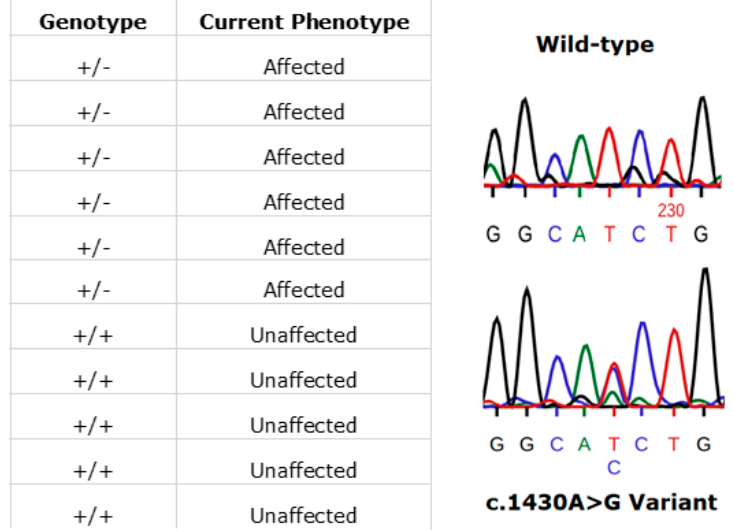
Figure 9. An illustration of patients harbouring the RPE65 c.1430A>G (p.D477G) variant. In this pedigree, each individual’s phenotype corresponds to the expected genotype (left image). Also shown is a representative Sanger sequence trace from an unaffected (wild-type) family member (right image, top). The variant sequence shown below is that from an affected family member (right image, bottom). Sequences were read from the sense strand so the observed change above is T>G (GGCA[T>G]CTG).